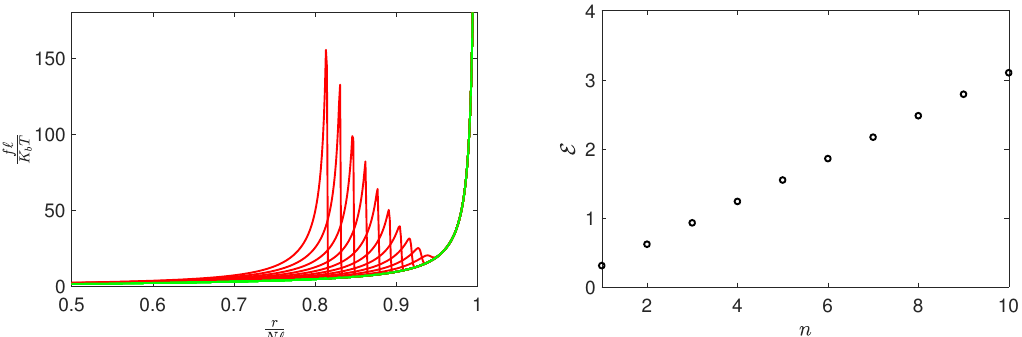
Figure 9. Helmholtz force–extension response (left panel, red curves) and extra-toughness (right panel, black symbols) for a chain with s = 1, an increasing length n of the sacrificial bond, and rupture energy proportional to the length. We also added the response of the same system without sacrificial bonds in order to compare the different behaviors (green curves). We assumed n = 1,2,3,..., 10 and the corresponding rupture energies are given by E / ( K b T ) = 20 n . The plots are represented with adimensional quantities. The other parameters are given by N = 50, h / k = 1, and d / (cid:96) = 1/10.